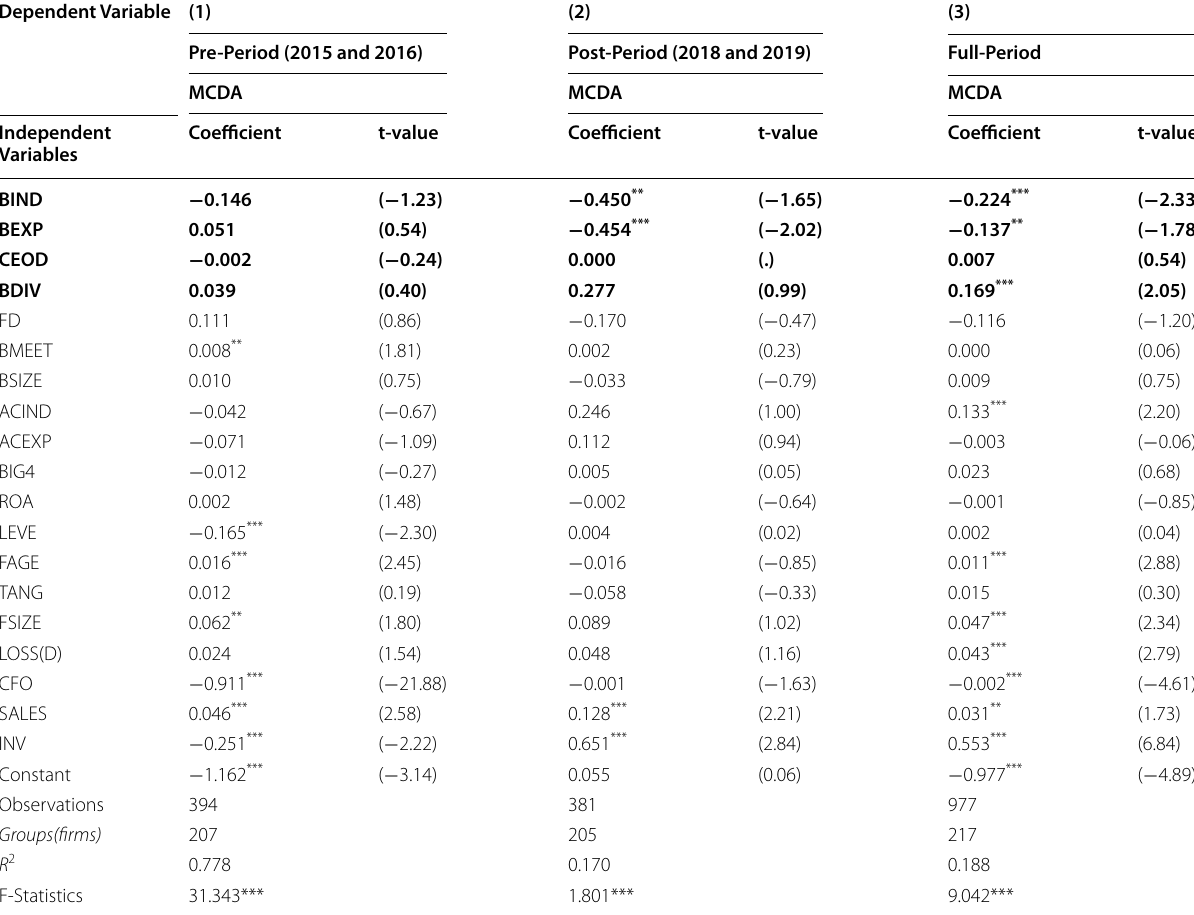
Table 8 Regression results of board of directors attributes and earnings management (Discretionary Accruals)